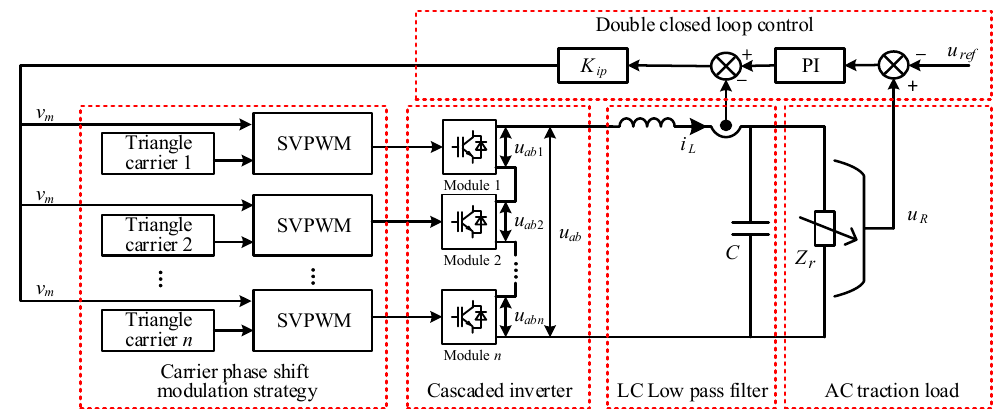
. Figure 3. The control strategy and modulation strategy of the three-phase three-level neutral point clamped (3L-NPC) rectifier. 2.3. The Control Strategy and Modulation Strategy of Single-Phase 3L-NPC Cascaded Inverter